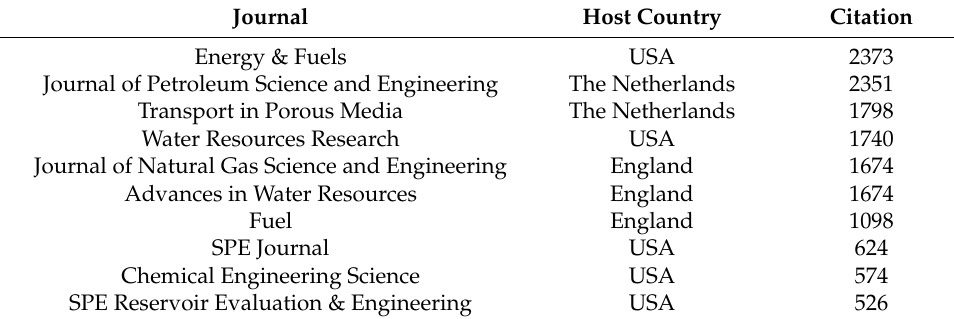
Table 4. Top 10 journals by citations.